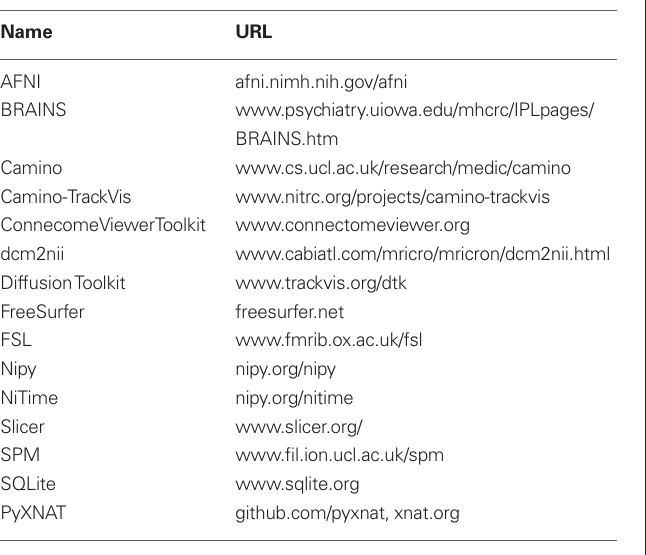
Table 2 | Supported software.